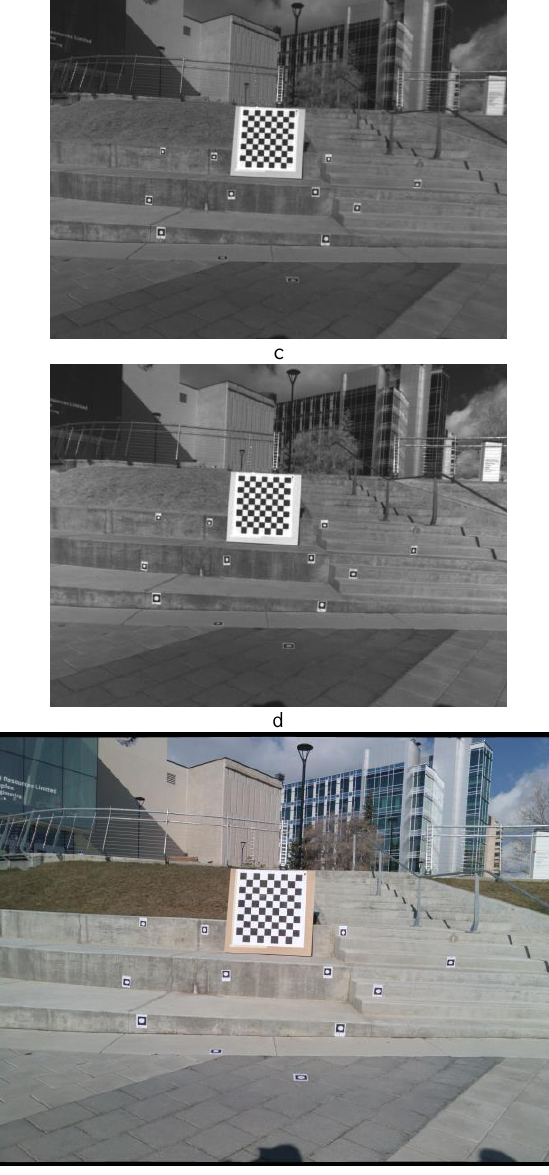
Figure 3. Rectified images; a) Red band; b) Green band; c) Red- edge band; d) Near-infrared band; e) RGB image Figure 4 shows the epipolar resampled REG and NIR images, as well as the disparity map, resulted from their dense